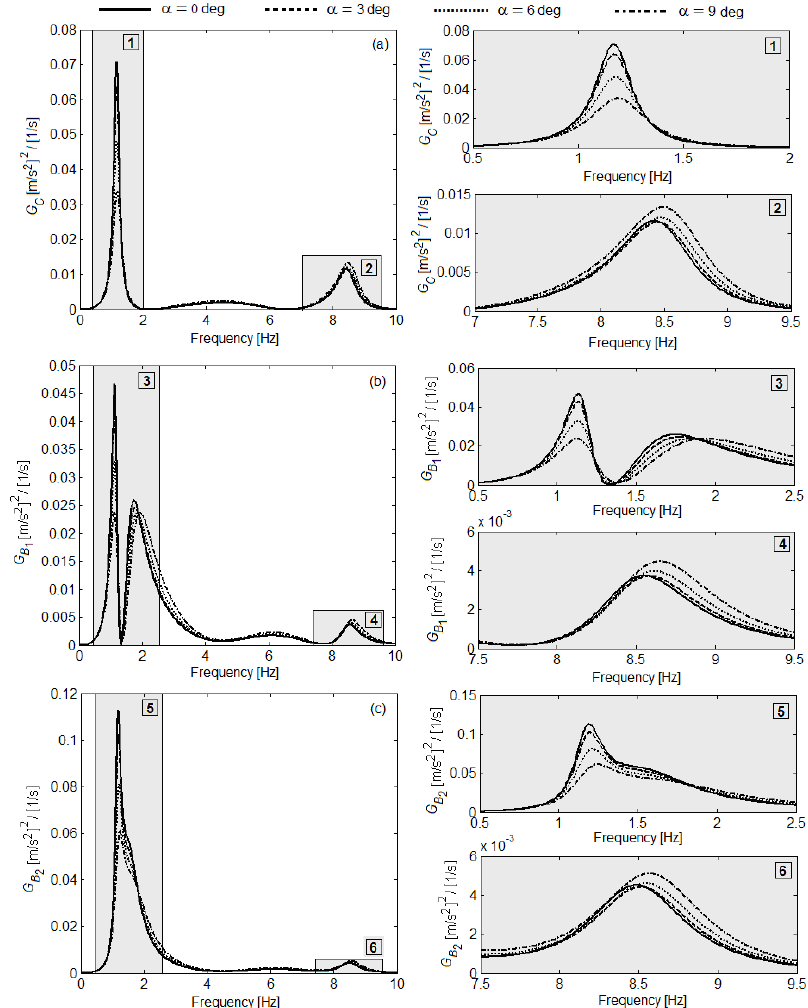
Figure 9. Influence of the mounting angle of the anti-yaw damper upon the power spectral density of the carbody acceleration: ( a ) at the carbody center; ( b ) against the front bogie; ( c ) against the rear bogie.